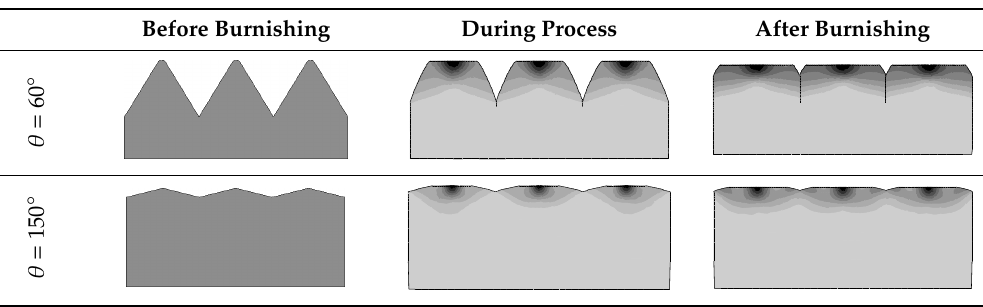
Table 3. Results of sample computer simulations.